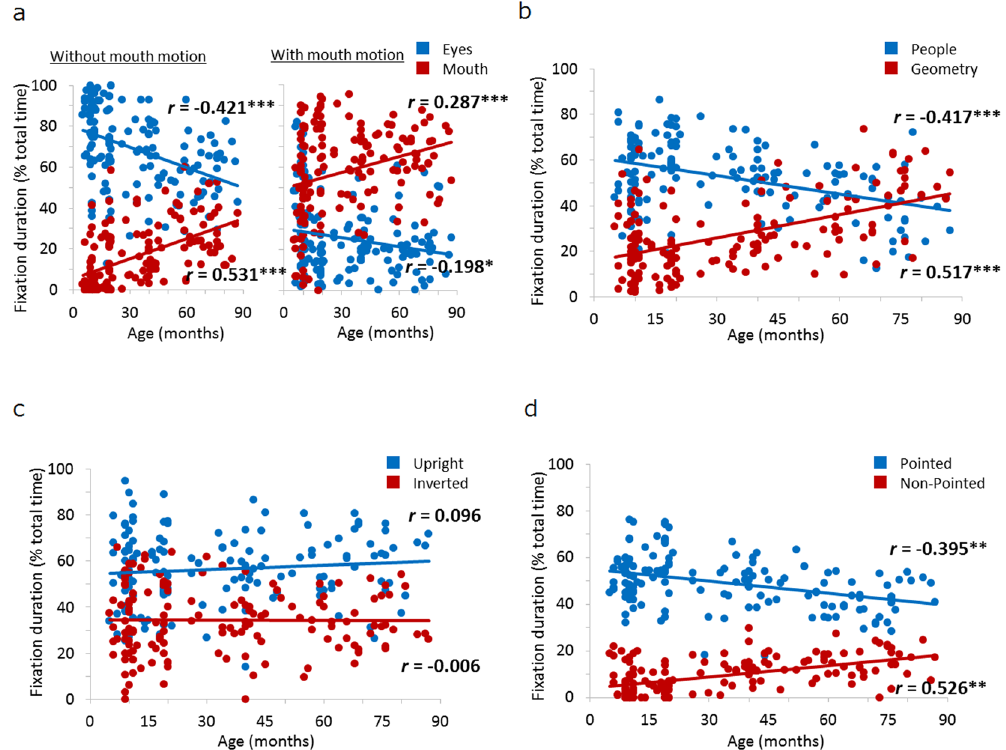
Figure 1. Correlations between age and percentage of the total time that eyes were fixated on social cues. ( a – d ). The vertical axis indicates fixation duration on each type of social stimulus as a percentage of total time measured. The horizontal axis indicates the age of the children in months. ** p < 0.01; *** p <